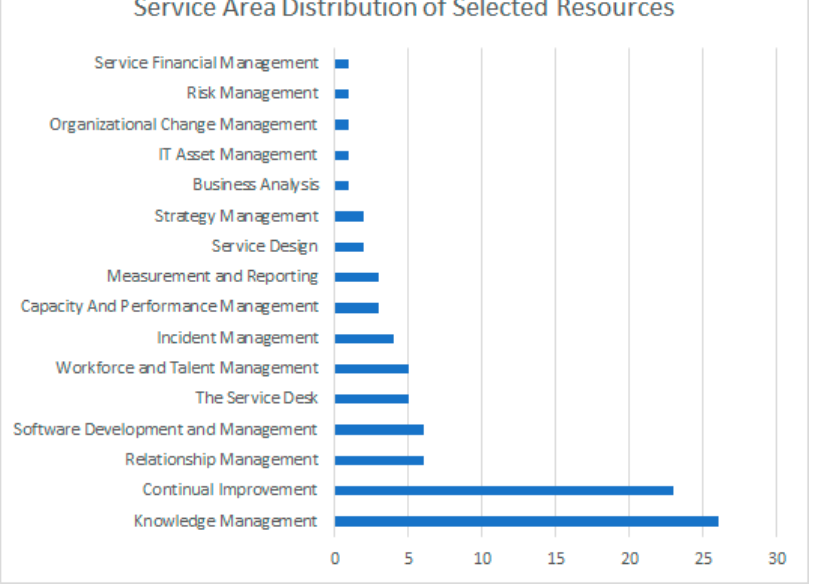
Figure 3. Service Area Distribution of Selected Sources According to ITIL Application